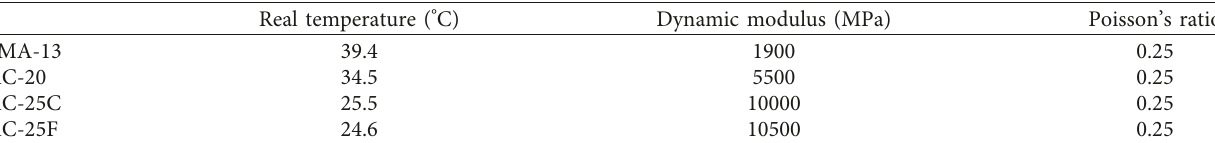
Table 6: Asphalt dynamic